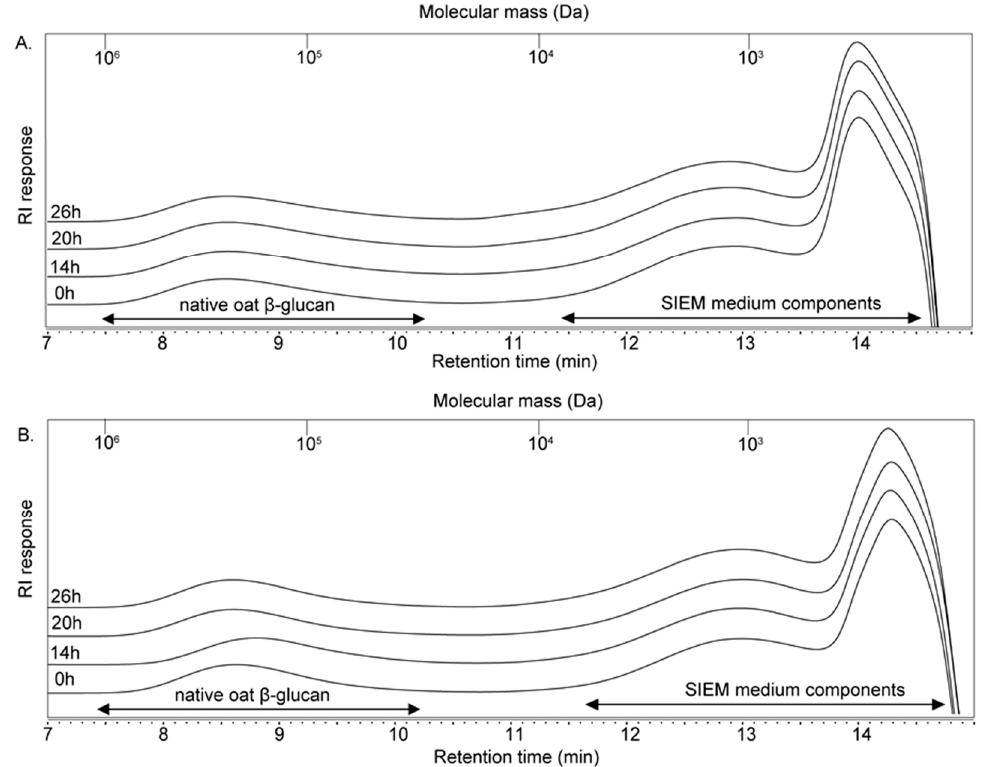
Figure 1. HPSEC profiles of native oat β -glucan at the start and after 14, 20 and 26 h of fermentation using pooled fecal inoculum of 2- ( A ) and 8- ( B ) week-old infants. Calibration of the system using pullulan standards is indicated.